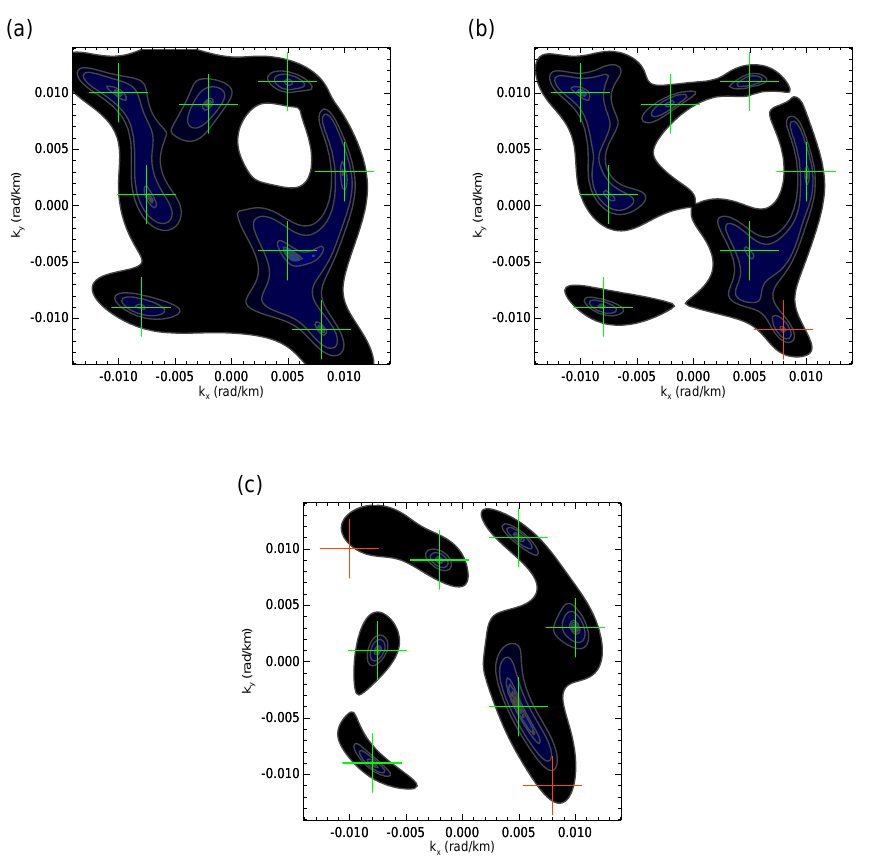
Figure 3. Estimated P(ω, k ) for (a) eight random-phase plane waves, (b) seven random-phase plane waves and one fixed-phase plane wave (red cross), (c) six random-phase plane waves and two fixed-phase plane waves. The contours denote 0.1, 0.5, 1, 10, 25, 30, 50, 80 and 90% of the maximum power, which cover the large range of powers estimated from the method